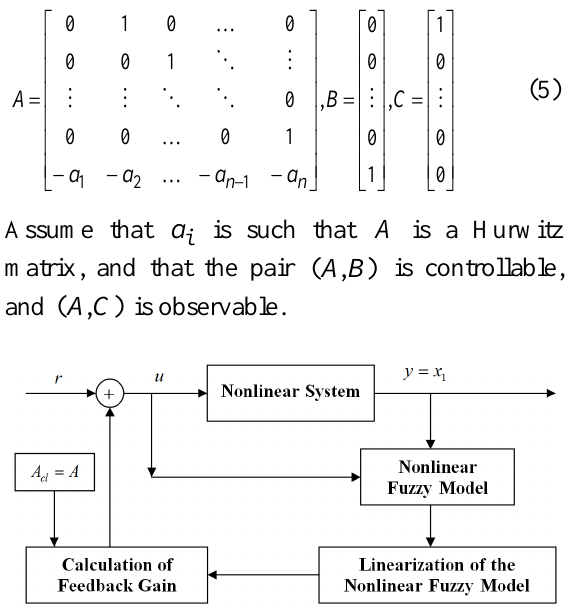
Figure 1. Structure of the proposed